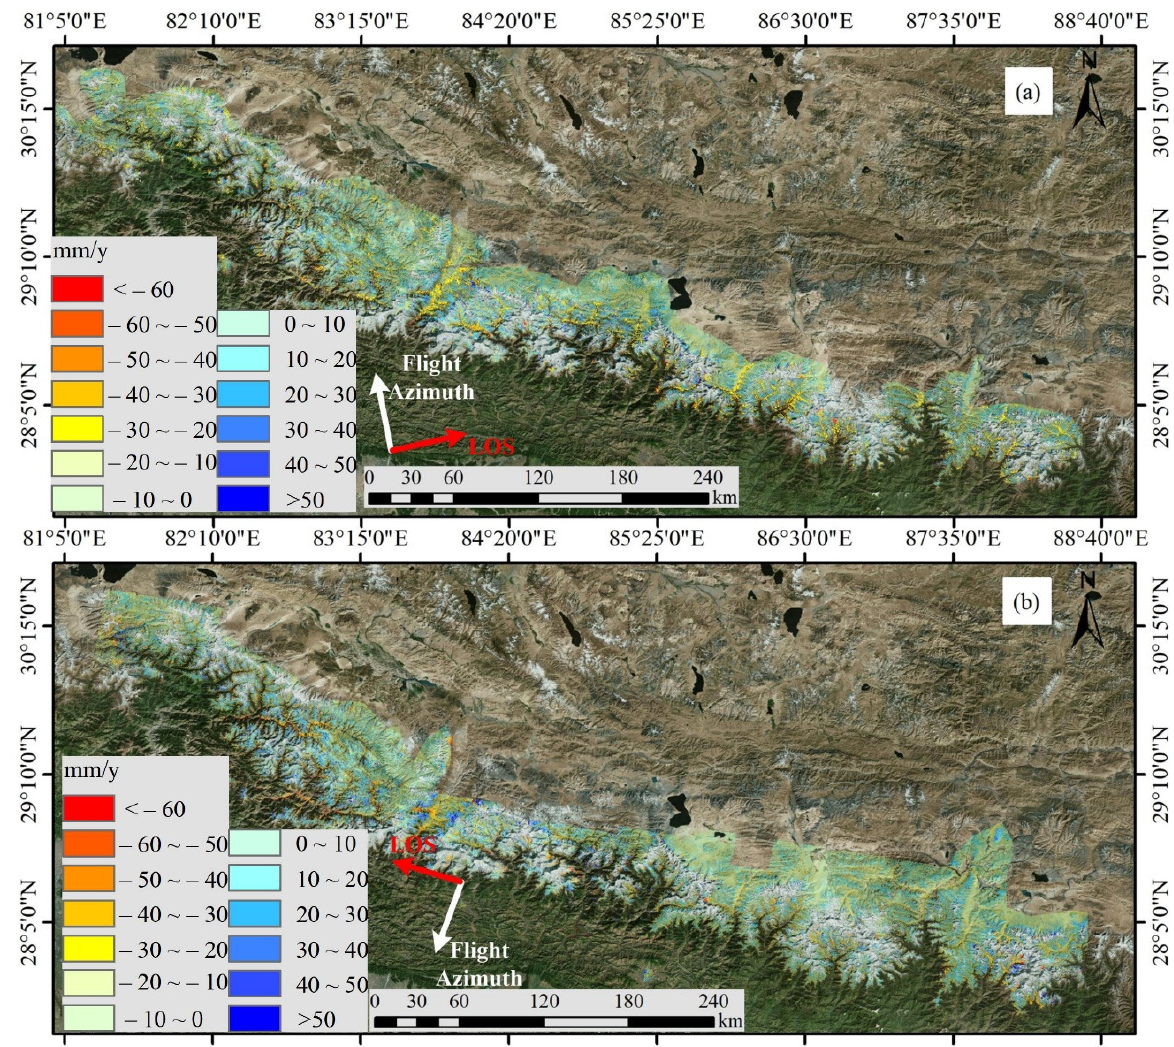
Figure 6. Line-of-sight (LOS) deformation velocities in the study area for ( a ) ascending data and ( b ) descending data. (The background is high resolution Bing satellite image.)